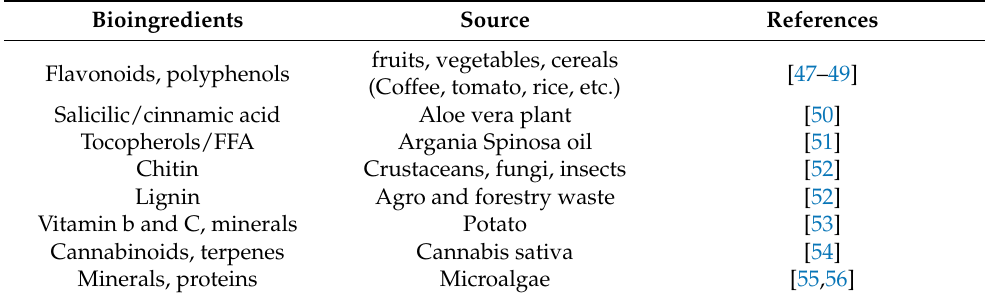
Table 1. Natural active ingredients of cosmetic use obtained from waste, microalgae, fungi and